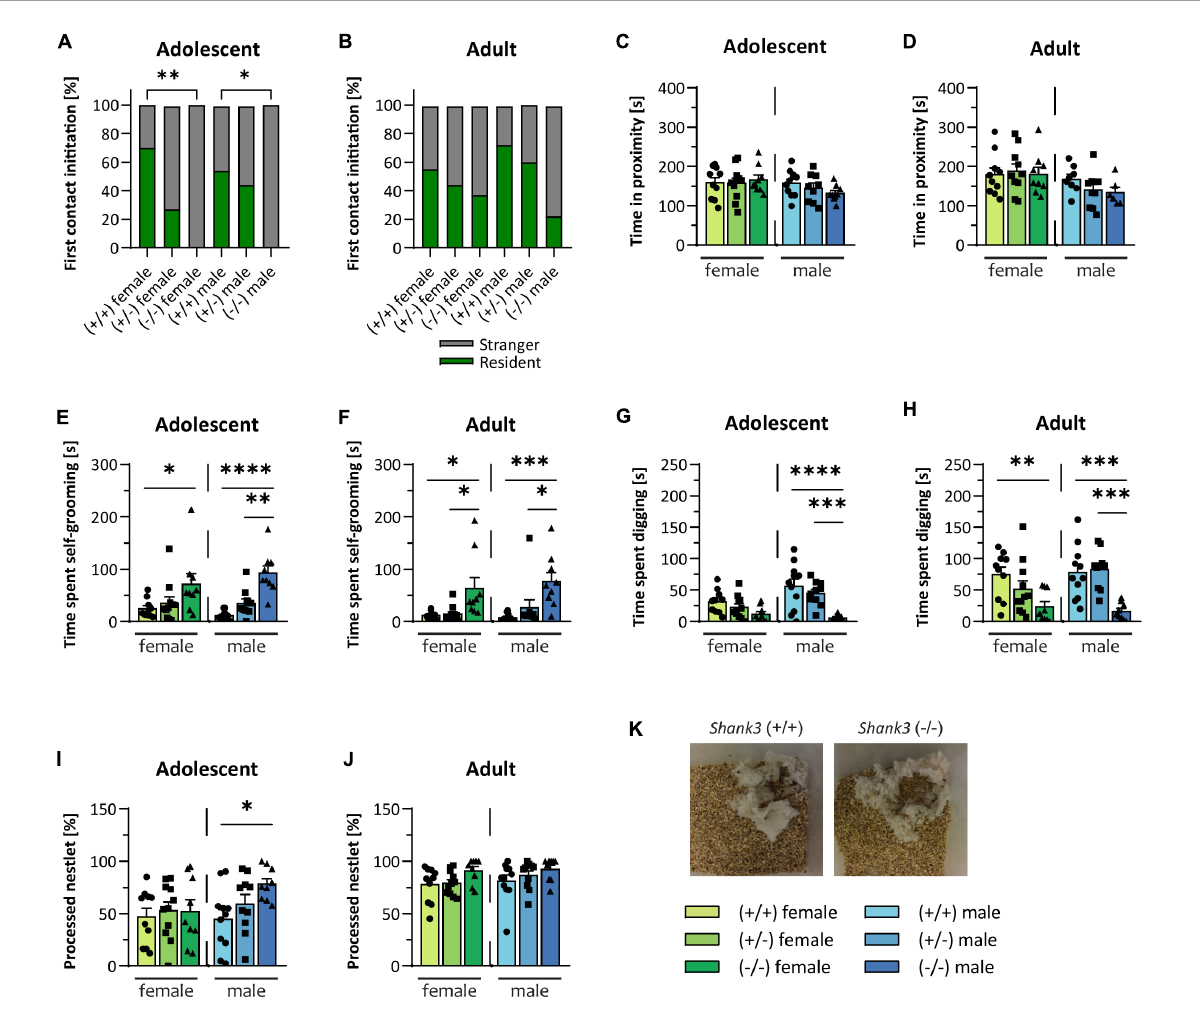
FIGURE2 Autism-related behaviors in Shank3 -transgenic mice. Social interest of Shank3 (+/–) and Shank3 (–/–) compared to wildtype was assessed in the direct social dyadic test, in which the testing animal was able to directly interact with a sex-and age-matched stranger conspecific. (A,B) Shows whether the first contact in the direct social dyadic test was initiated by the testing mouse or the stranger mouse. (C,D) The time the two animals spent in close proximity to each other in the direct social dyadic test are determined. Different behaviors (E–H) were recorded within a 10 min observation session (after 10 min of habituation to a new cage). (E,F) The time spent self-grooming and (G,H) the digging time (moving the cage bedding with front and/or hind paws) were analyzed. (I,J) In the nest building test, the amount of shredded cotton nestlet was determined. (K) Representative images of processed nestlets from a wildtype (left) and a Shank3 (–/–) (right) mouse are displayed. All data are represented as means with SEM with 9–11 animals per group. Significance levels ( p –values) are set to 0.05 ( p ≤ 0.05 ∗ , p ≤ 0.01 ∗∗ , p ≤ 0.001 ∗∗∗ , p ≤ 0.0001 ∗∗∗∗ ) with 95% confidence interval. See Supplementary Table 3 for detailed statistical